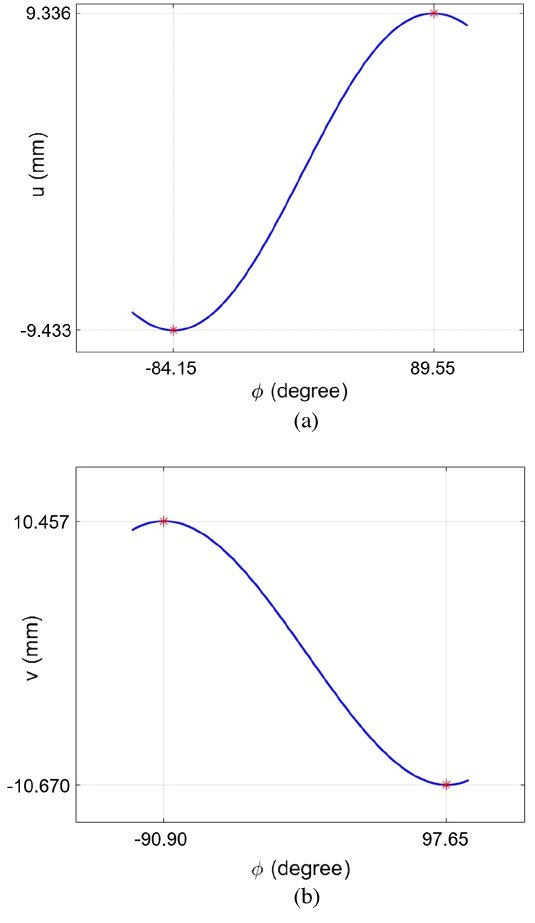
FIG. 10. Theoretical adjusting ranges in the directions of (a) horizontal and (b) vertical.